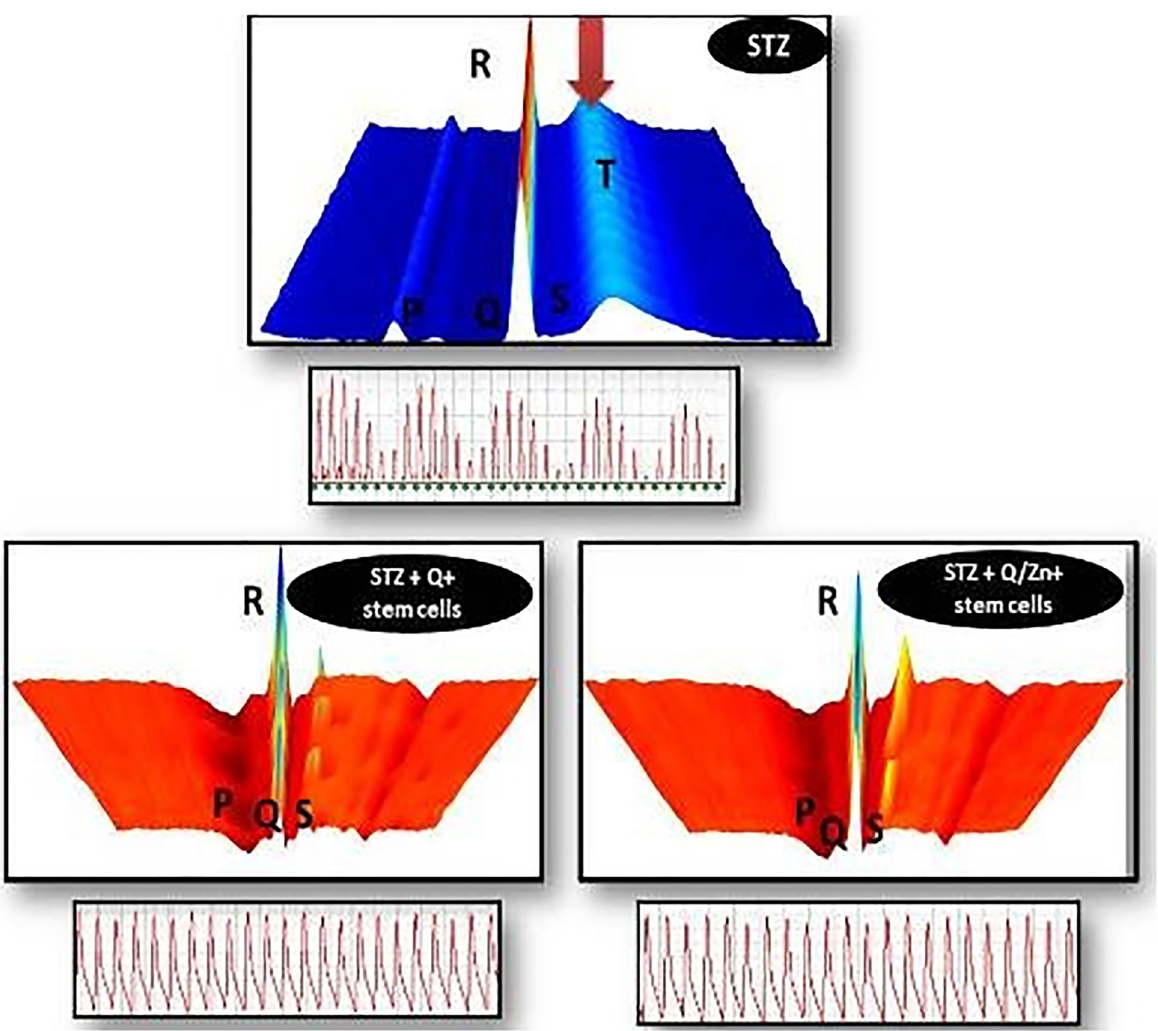
Fig 13. Illustrative 3D parametric ECG displays radial velocity with the lab chart software. STZ group showing blue color, which indicates incidence of oxidative stress, and highly wavy (P and T) waves, with the appearance of faint blue color, which indicates cardiac cell necrosis and area of non-clearance flow with more irregular electrocardiogram. STZ + Q + stem cells showing normal heart beat, with characteristic points (P,Q, R, S) and normal signal as (P) represents contraction of the heart and movement of blood from up down the heart, (QRS) represents ventricular contraction and appears above other signals, (T) represents the relaxation of the heart and pulse end with normal waves and appearance of rich oxygenated red color with less oxidative stress damages with mild waves. STZ + Q + stem cells showing normal heart beat with characteristic points (P,Q,R, S) and normal waves and appearance of rich oxygenated red color with less oxidative stress damages with more regular waves than Q alone with stem cell with normal